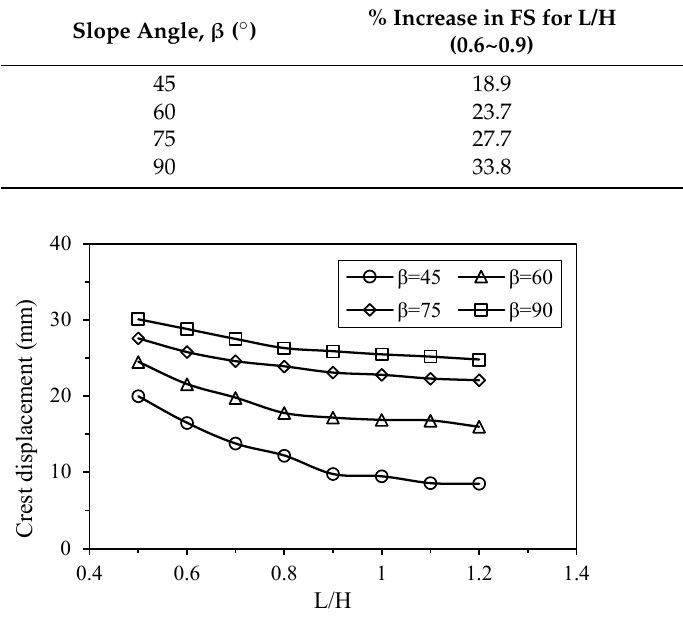
Figure 8. Influence of L/H on slope crest displacement with horizontal